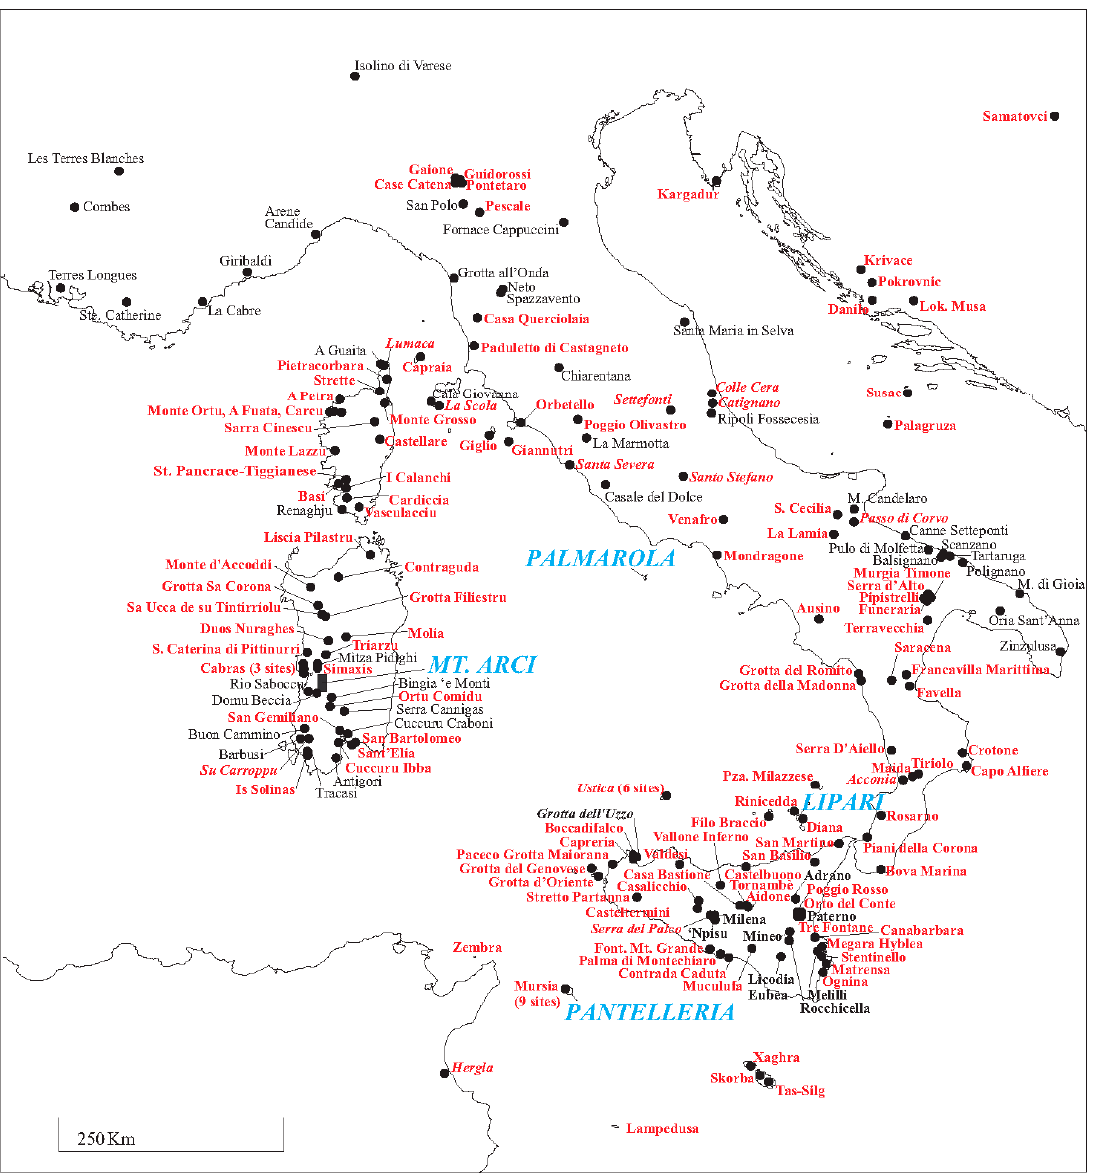
Figure 10. Map of central Mediterranean showing archaeological sites with ≥ 10 source analyses of obsidian artifacts. Sites in red analyzed by the author.